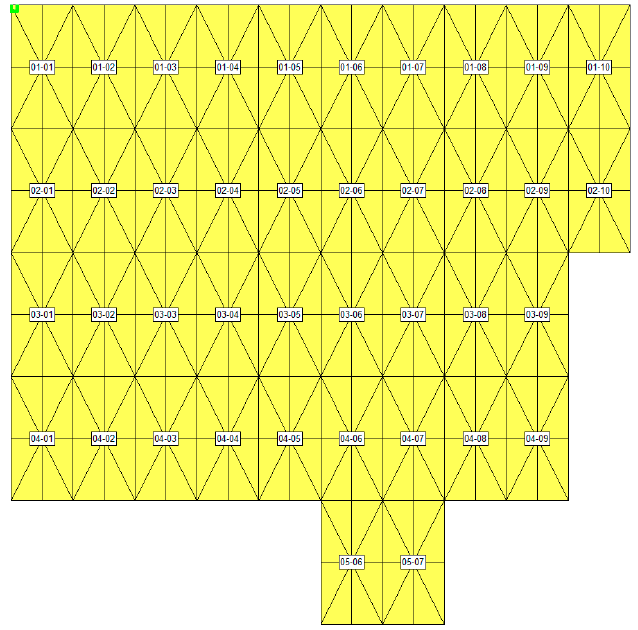
Figure 12. Layout of the smart floor in the UJAmI